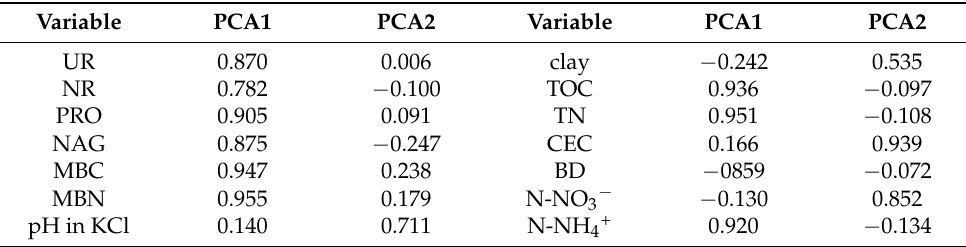
Table 5. Loading scores of the variable for